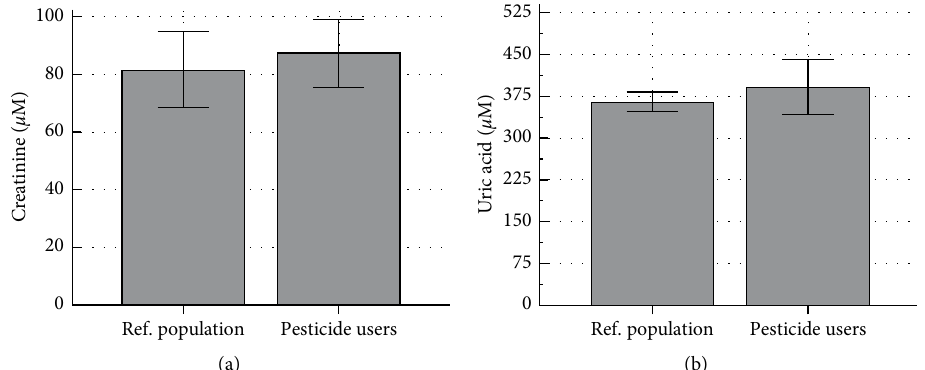
Figure 4: Serum levels of creatinine (a) and uric acid (b) in a reference population and agro pesticide users. Ref. population: Reference